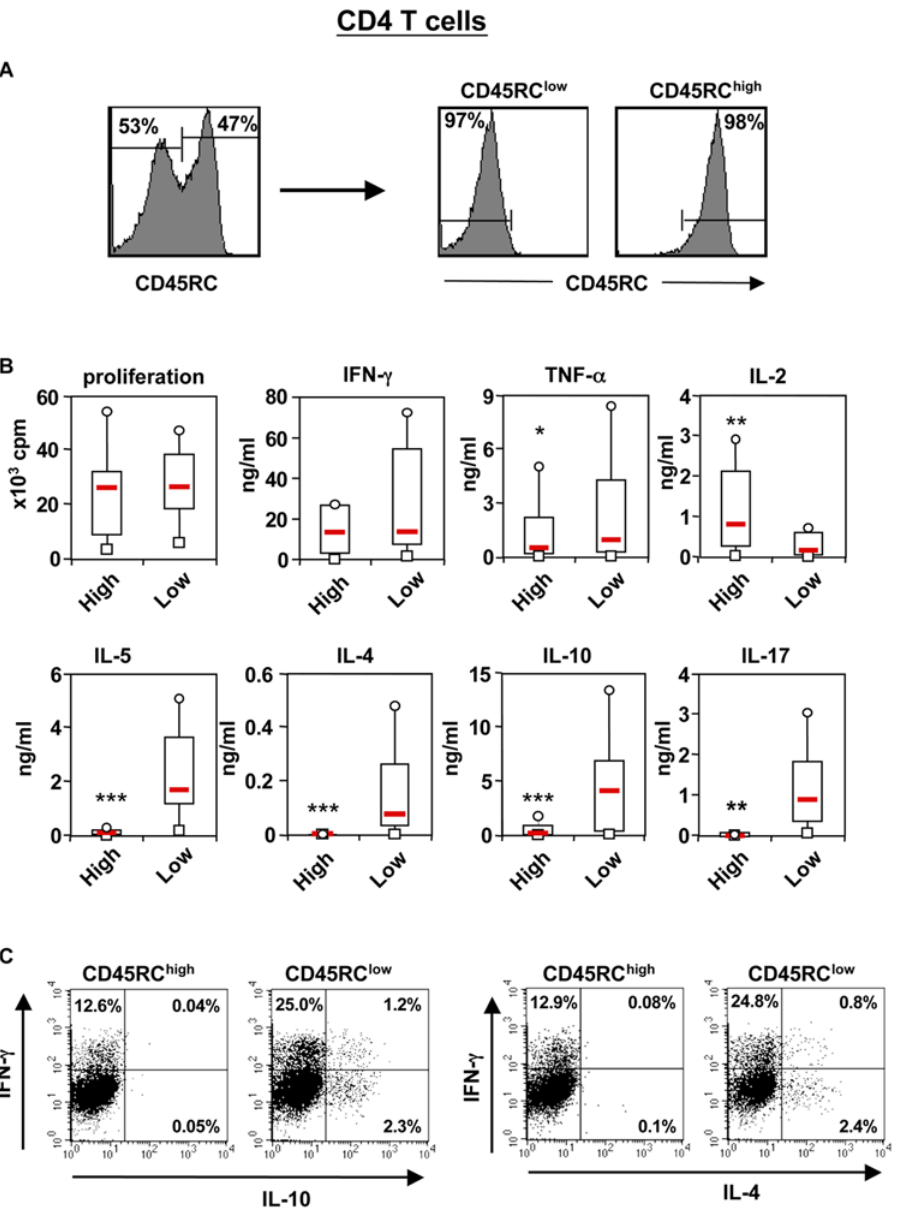
Figure 4. Cytokine profile of human CD45RC CD4 T cell subsets. ( A ) Representative example of the purification of CD4 CD45RC T cell subsets. Results are shown as histograms for CD45RC expression on CD4 T cells before (left histogram) and after CD45RC subsets purification (right histograms). The values within the histograms represent the percentage of CD45RC T cell subsets. ( B ) Purified CD45RC high (High) and CD45RC low (Low) CD4 T cell subsets, were stimulated in vitro with plate-bound anti-CD3 and anti-CD28 mAbs. The supernatants were collected at 72 h of culture and analyzed for the presence of cytokines using the CBA kit and Elisa. The results obtained in 20 healthy individuals are presented as box plot diagrams. The p-values were calculated using the Wilcoxon matched-pairs test; *, p , 0.05; **, p , 0.02; ***, p , 0.002. ( C) For intracellular measurement of cytokines, purified CD4 CD45RC high and CD45RC low T cells were stimulated and stained using FITC-labeled anti-IFN- c mAb and PE-labeled anti-IL-4 or anti-IL-10 mAbs. The results are expressed as dot plot representing IFN- c /IL-4 or IFN- c /IL-10 production by CD4 T cell subsets. The values within the plots represent the fraction of CD4 T cells producing the indicated cytokine. The results are representative of three independent experiments.